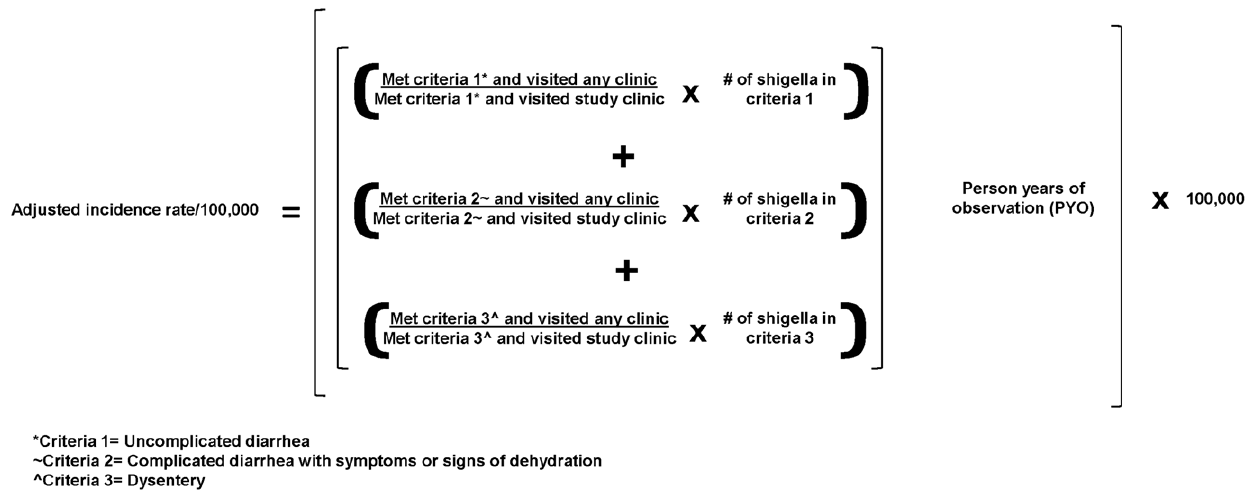
Figure 1. Formula for adjusted incidence rate calculations.